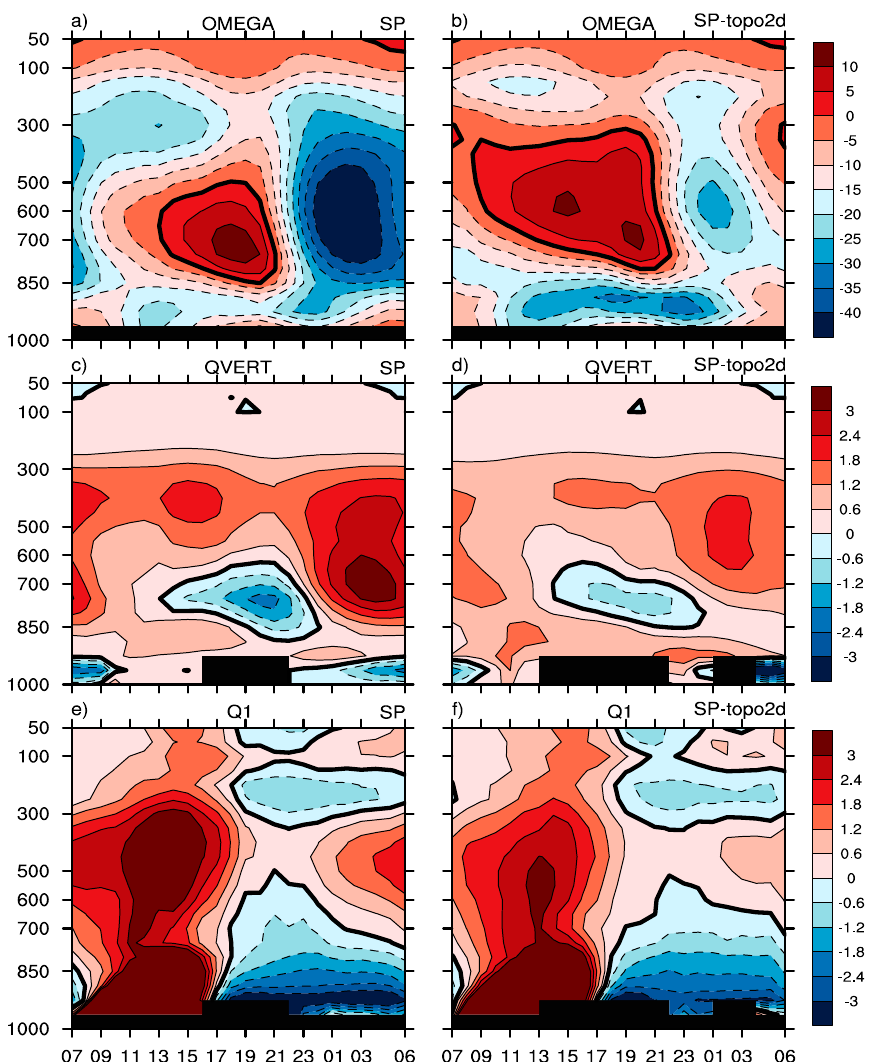
Figure 8. The hour–pressure transects (eastern plain) averaged within 32–36 ◦ N, 113–118 ◦ E, ( a , b ) the pressure vertical speed (hPa · day − 1 ) in SPCAM5 and SPCAM5-topo2d, ( c , d ) the vertical moisture advection (K · day − 1 ) in SPCAM5 and SPCAM5-topo2d, ( e , f ) Q 1 (K · day − 1 ) in SPCAM5 SPCAM5-topo2d.